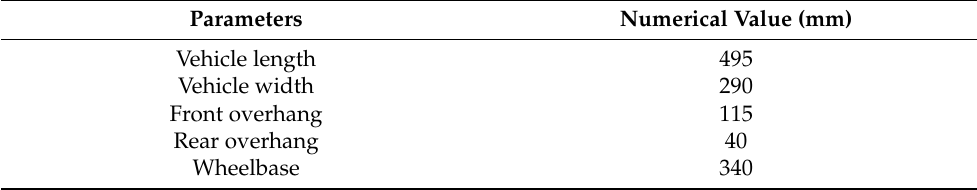
Table 5. Basic parameters of intelligent